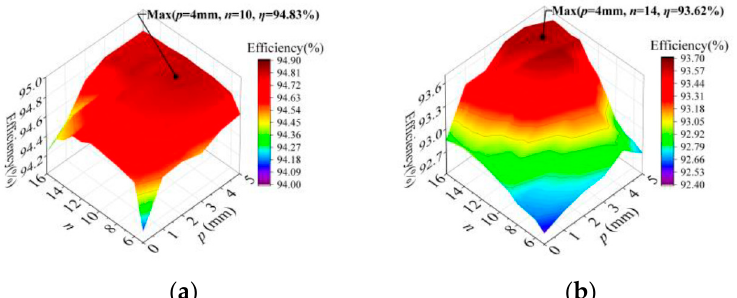
Figure 13. PTE of ground transmitting coil with different values of n and p , at distances of ( a ) 5 cm and ( b ) 10 cm.